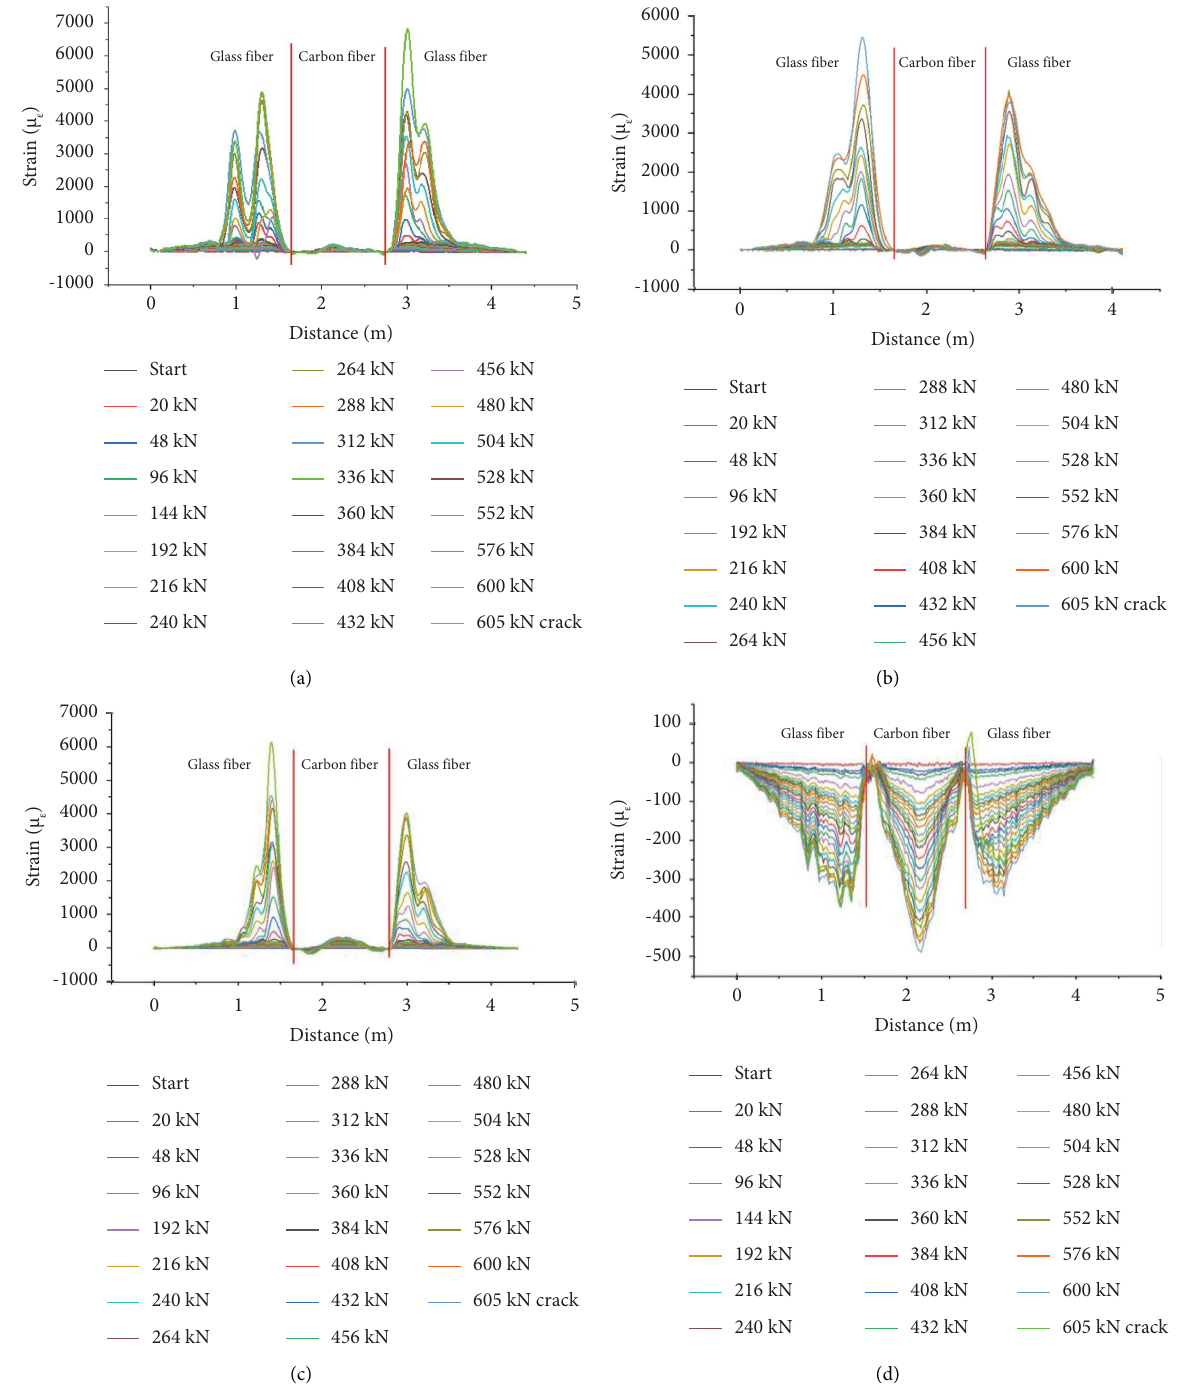
Figure 8: Strain diagram of glass fber optical cable on the top, back, and front of 5-1. (a) Top. (b) Back. (c) Upper of front. (d) Lower of